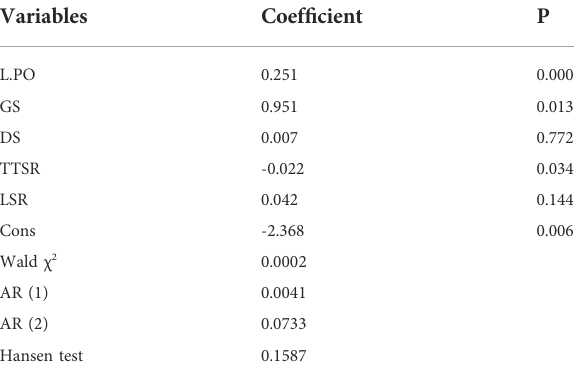
TABLE 10 Generalized Method of Moments results of PO.